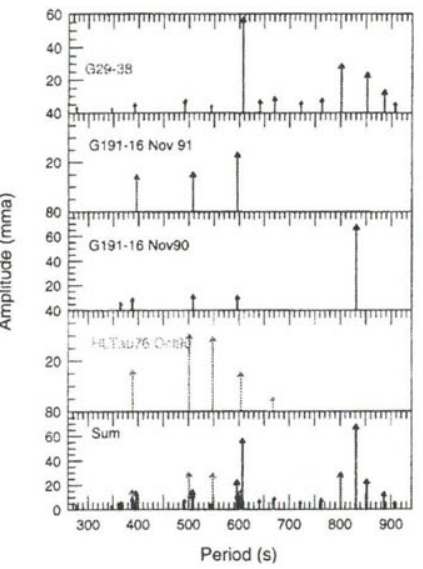
Fig. 21. The shifted non-combination modes of the cool